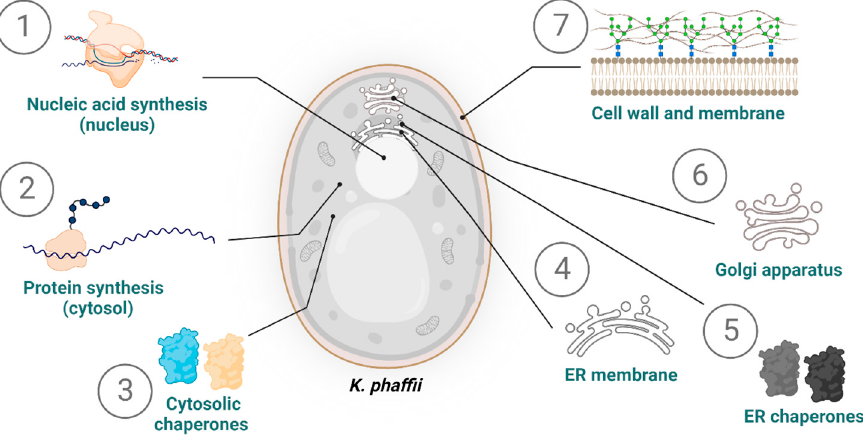
Figure 3. Targets for the engineering of K. phaffii for an increase in protein production and secretion. This involves several steps, factors, and cellular components: (1) nucleic acid synthesis in the nucleus; (2) protein synthesis in the cytosol; (3) cytosolic chaperones; (4) ER membrane, including the translocation into the ER and related trafficking (e.g., from ER to Golgi apparatus); (5) ER chaperones; (6) Golgi apparatus; (7) cell wall and membrane. The secretion of the recombinant protein into the medium is generally preferred; therefore, these engineering targets are guided to achieve a high concentration of secreted recombinant protein. ER = endoplasmic reticulum.